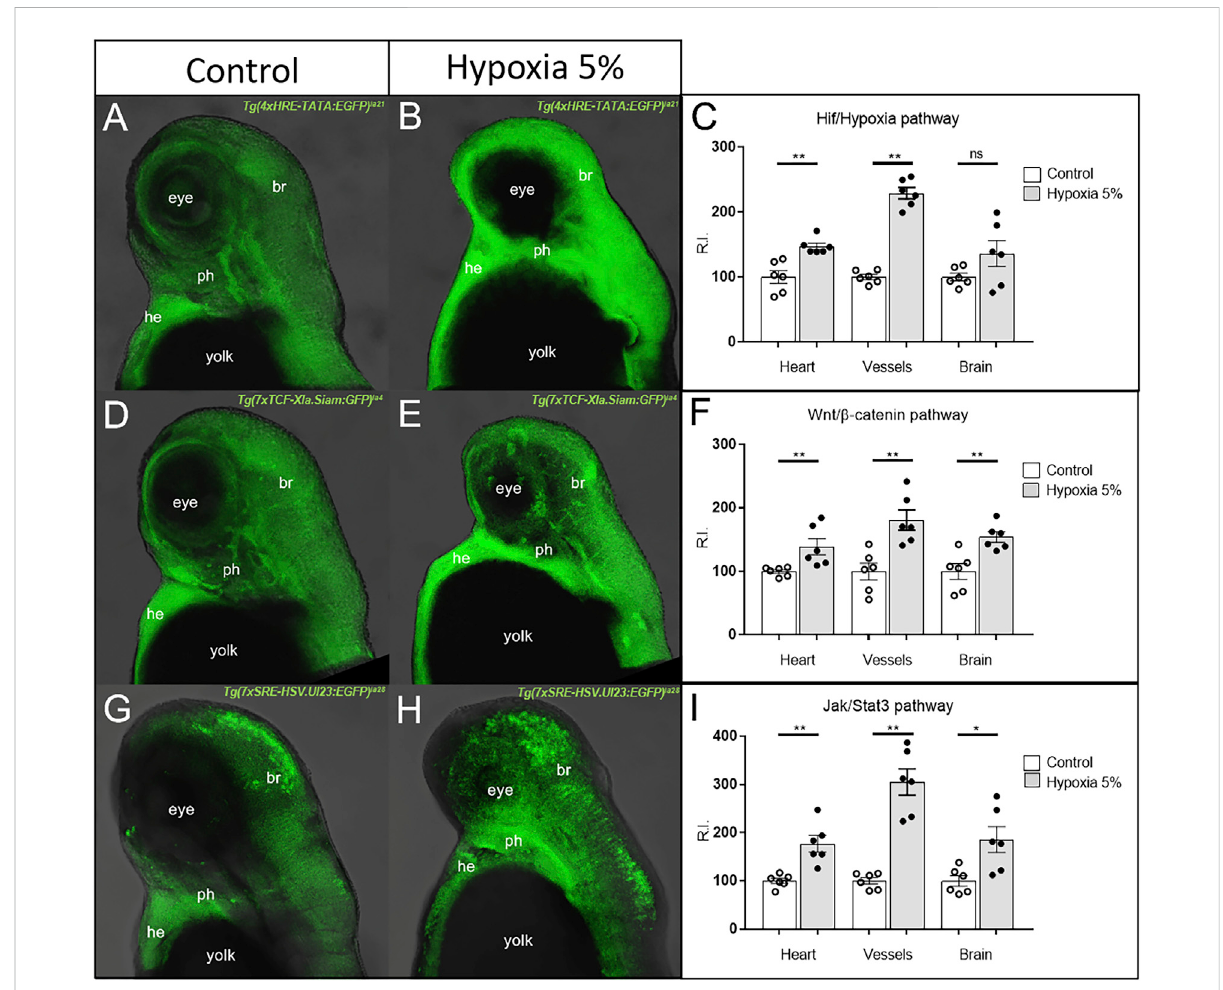
FIGURE 4 Hyper-activation of Hif/Hypoxia, Wnt/ β -catenin and Jak/Stat3 signalling in the cardiovascular and brain regions of hypoxia-treated zebra fi sh. TheGFP-based(green)reportersforHif/Hypoxia (A – C) ,Wnt/ β -catenin (D – F) andJak/Stat3 (G – I) signallingshowupregulationofthethreepathways in all considered anatomical regions. All embryos are at 3 dpf and displayed in lateral view, anterior to the top. br = brain; he = heart; ph = pharynx. Sample size: n = 6 per condition; ns = not signi fi cant; * = p < 0.05; ** = p < 0.01; R.I. = Relative Intensity. Test: Unpaired